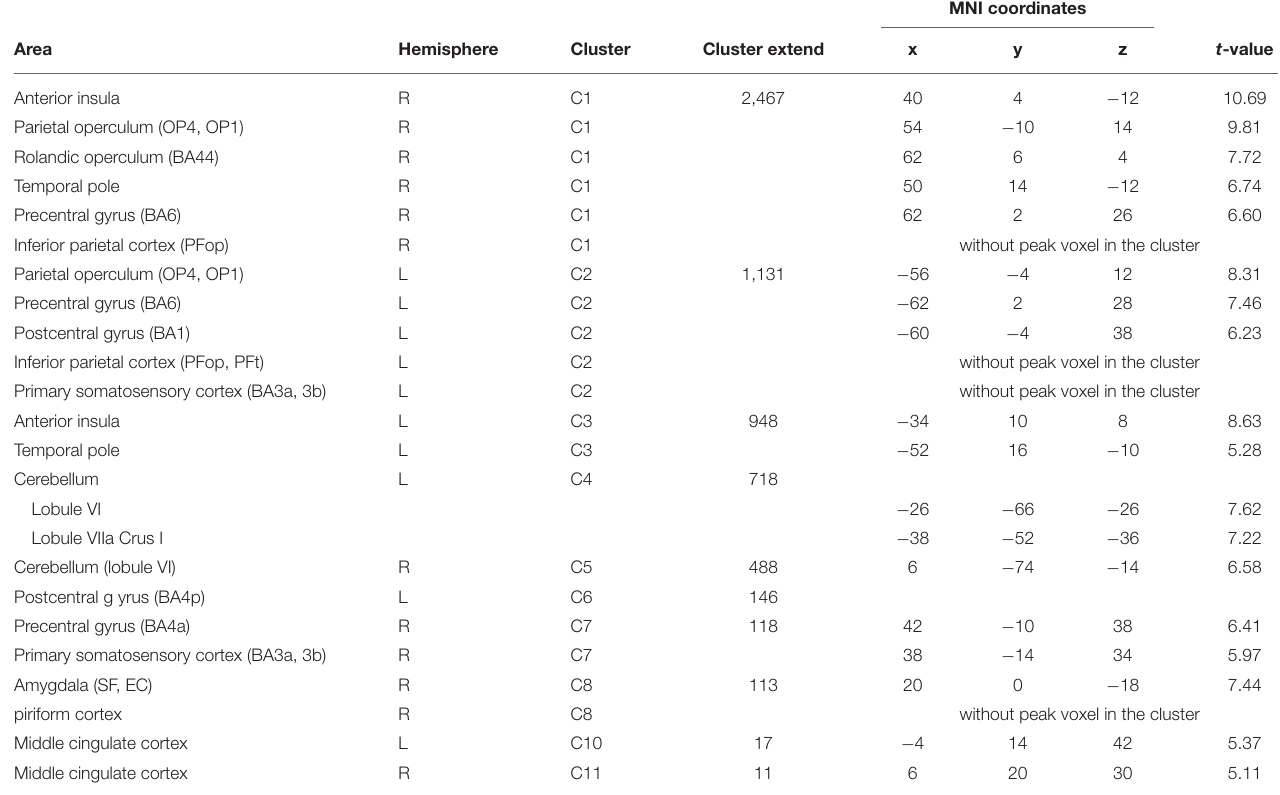
TABLE 3 | Activations during negative > neutral olfactory stimulation (O − > O 0